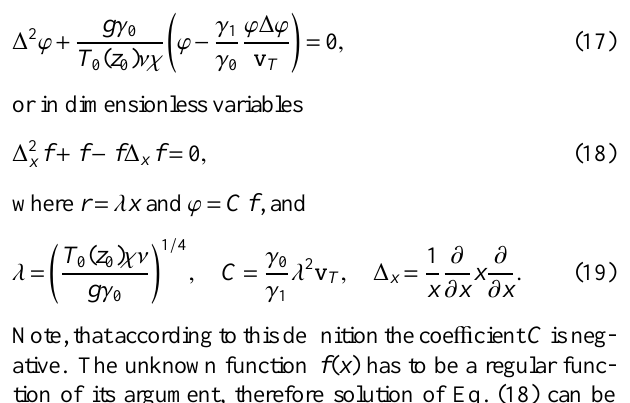
Figure 3. Profiles of velocity components in a non-rotational ap- and A . The proximation. Values of parameters are listed at the end of Section 2 3. Notice a factor in front of the radial velocity component v . r